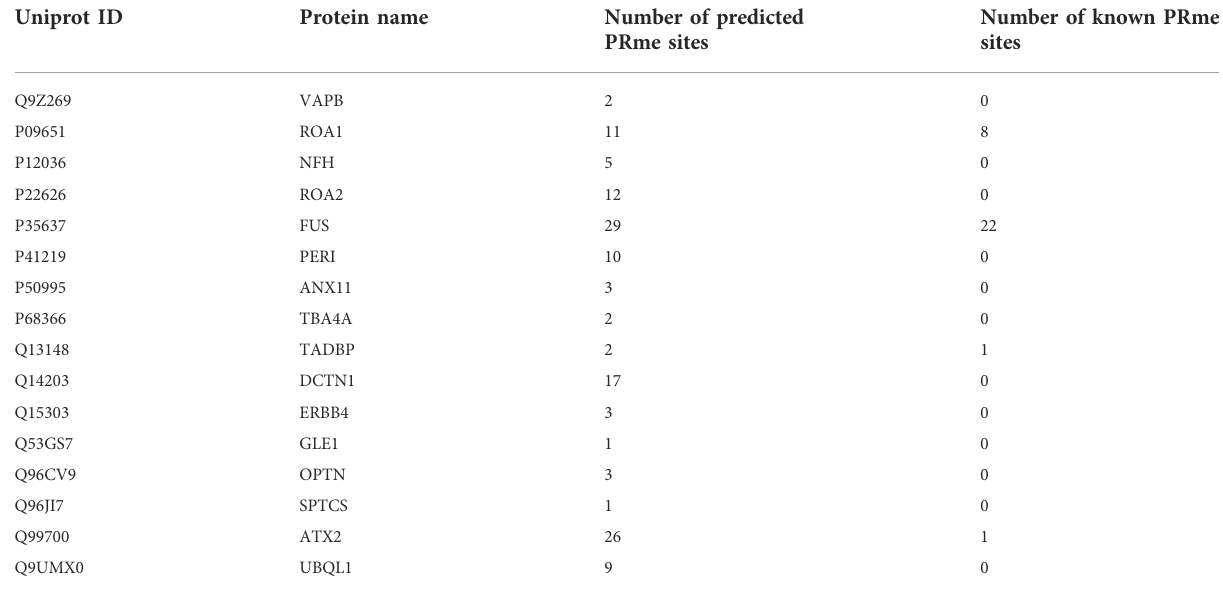
TABLE 3 Number of PRme sites in the ALS-related